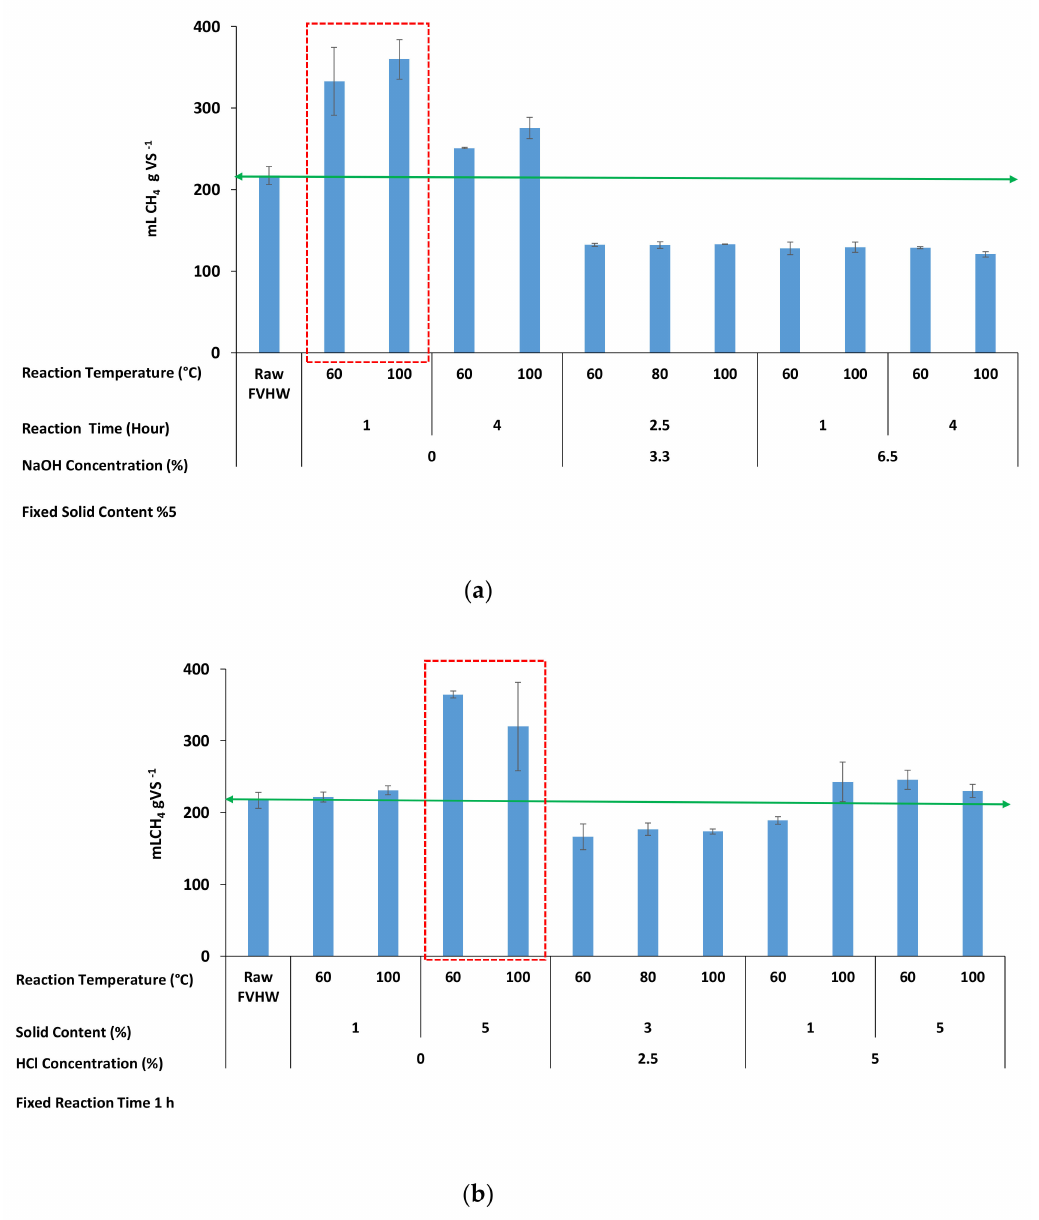
Figure 3. Methane production profiles after the NaOH-assisted thermal pretreatments ( a ); HCl-assisted thermal pretreatments ( b